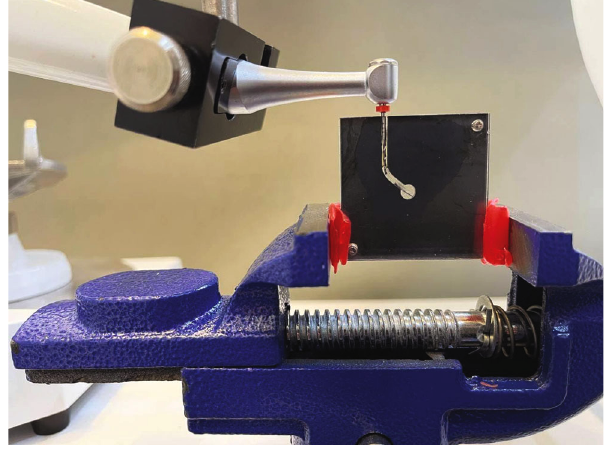
Figure 3: Instrument